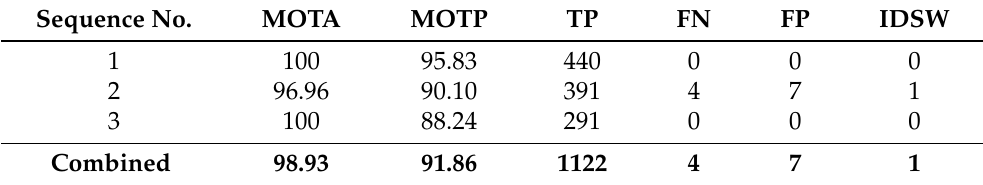
Table 4. Scenario 2—category 1 Quantitative results of the tracker’s performance to track objects of category 1 (large vessel) in scenario 1. Scenario 1 consists of three sequences involving only moving objects, and no occlusion or dynamic movement of the camera is applied.